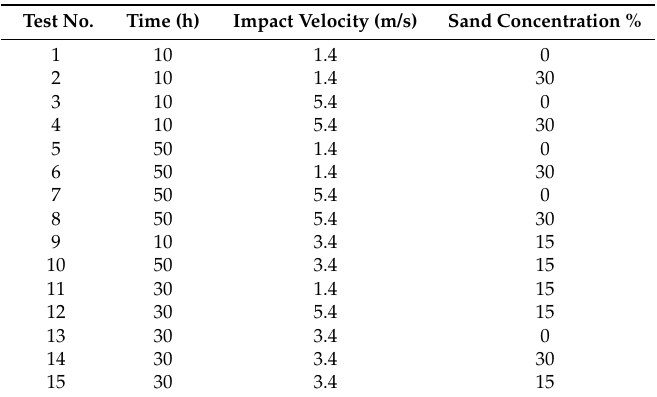
Table 3. Combinations of test points for the experiments.